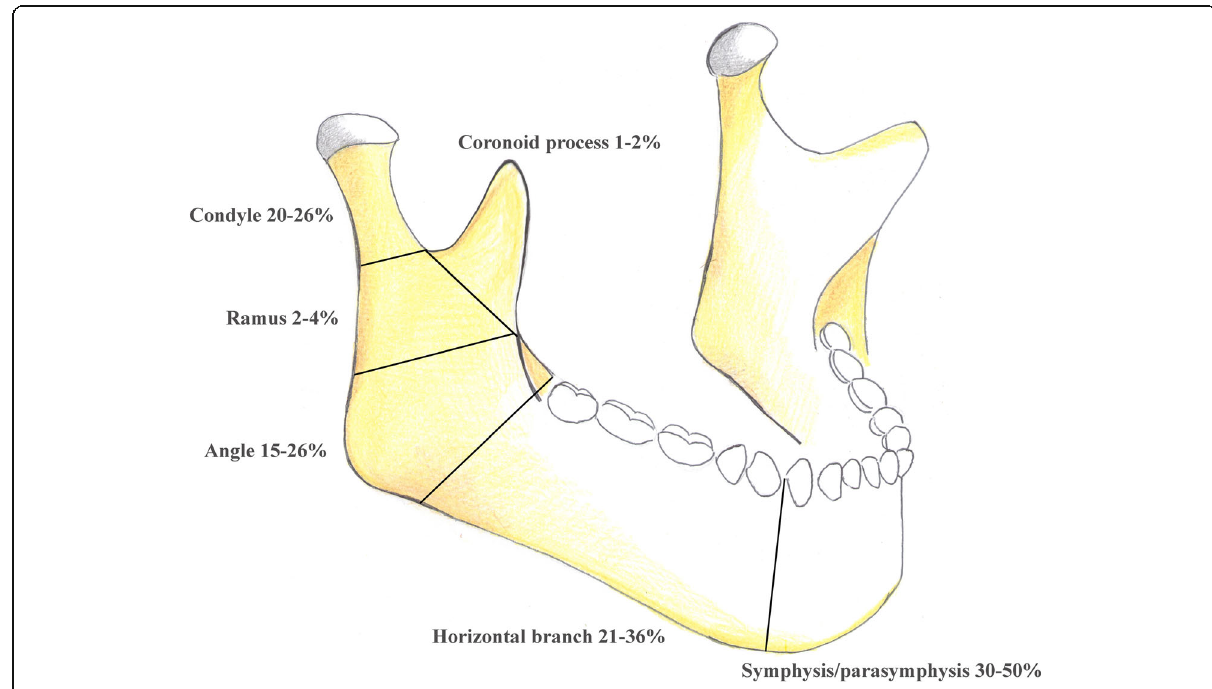
Fig. 1 Anatomic areas of mandibular fractures